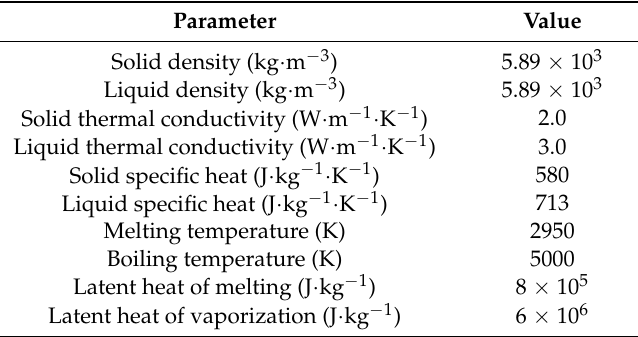
Table 2. Material properties of ZrO 2 .